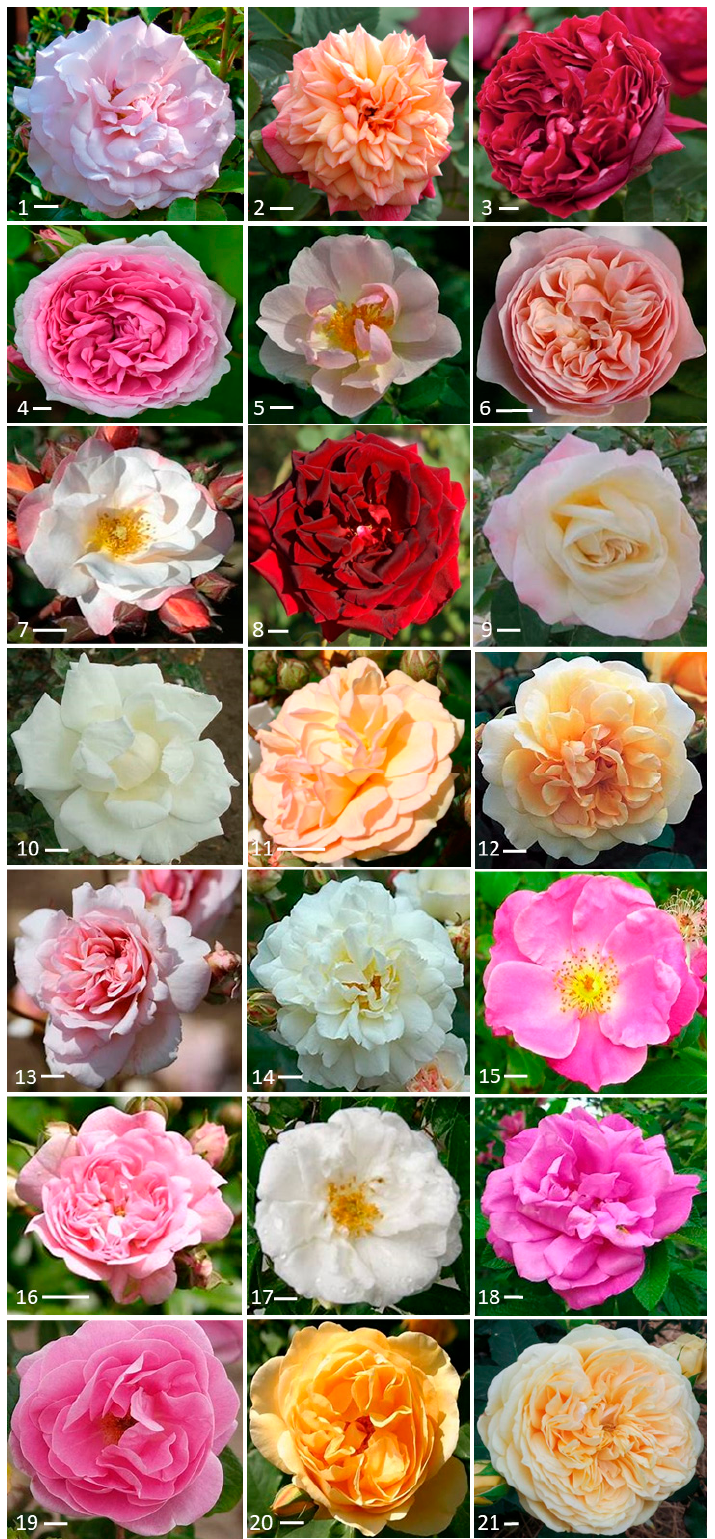
Figure 1. Flowers of the 21 studied garden rose genotypes (for the identification code see Table 1). The white scale bars within each figure indicate a 2 cm length.